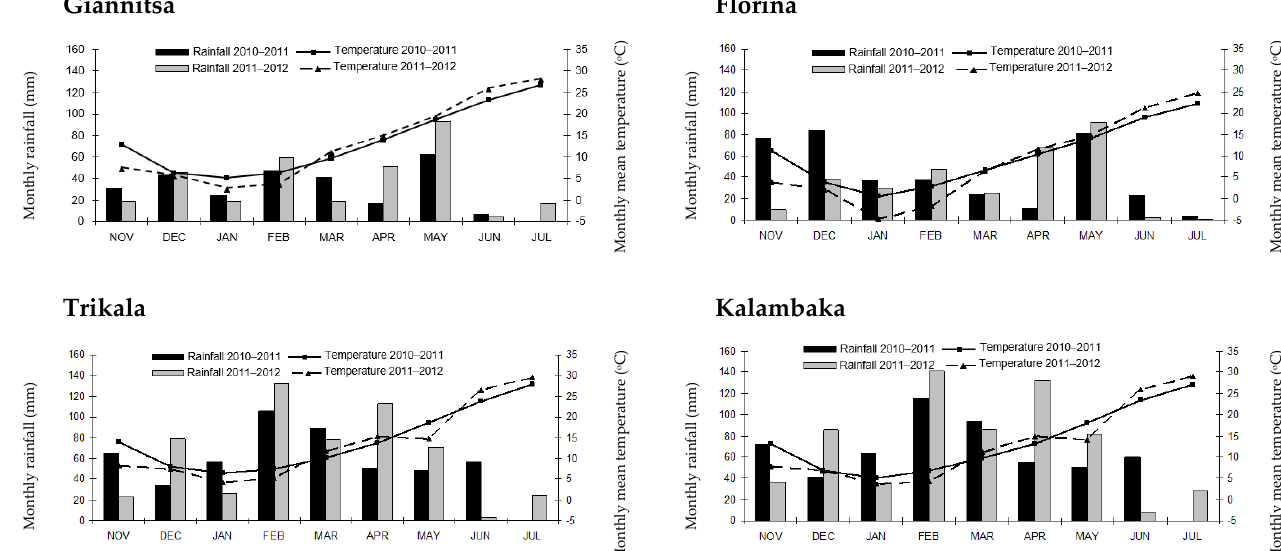
Figure 1. Basic weather data (mean monthly temperatures in ◦ C and rainfall in mm) based on daily records for two years. Six varieties of common vetch ( Vicia sativa L.), namely, cv. Filippos, cv. Omiros, cv. Alexandros, cv. Tempi, cv. Zefyros and cv. Pigasos, were used. The cultivation was conducted using a strip-plot design with the six varieties randomized within each plot. Each plot consisted of seven rows 5 m in length and the rows were spaced 25 cm apart. The plot size was 8.75 m 2 .